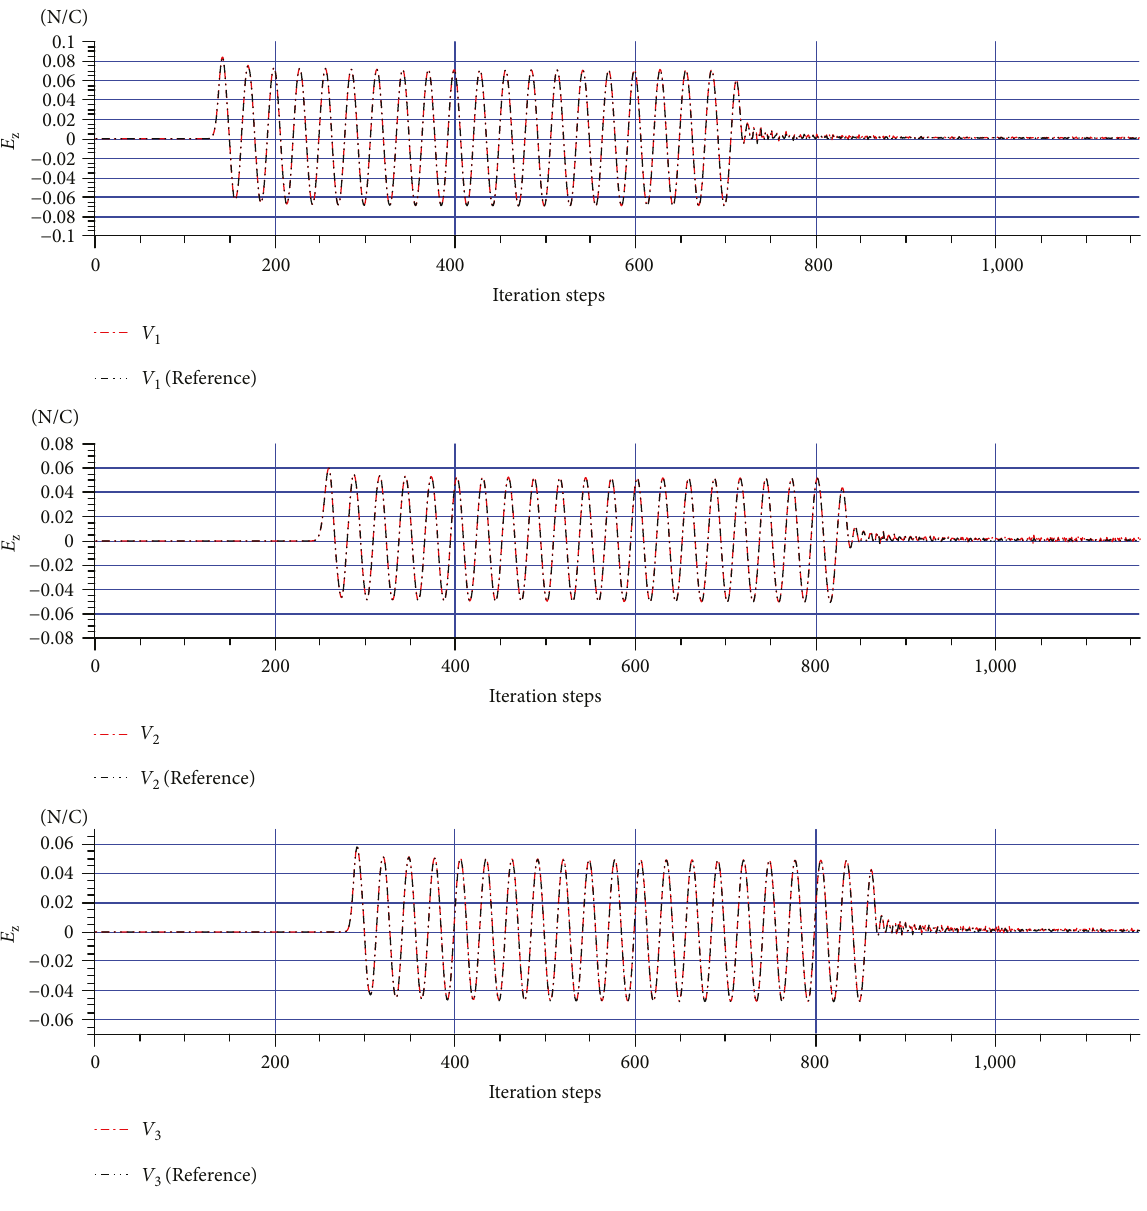
Figure 8: Energy decay as a function of time for free propagation experiment. It can be observed that when the source is turned o ff ( n = 580 ), the energy is adequately absorbed by the CPML ABC. Table 2: Mean squared error ( E z ) for each viewer compared with the reference solution for 2.45GHz, 5.00GHz, and 20.00 GHz frequencies. For 5.00GHz, we iterated up to n = 3480 time steps and the source is turned o ff at n = 1160 time